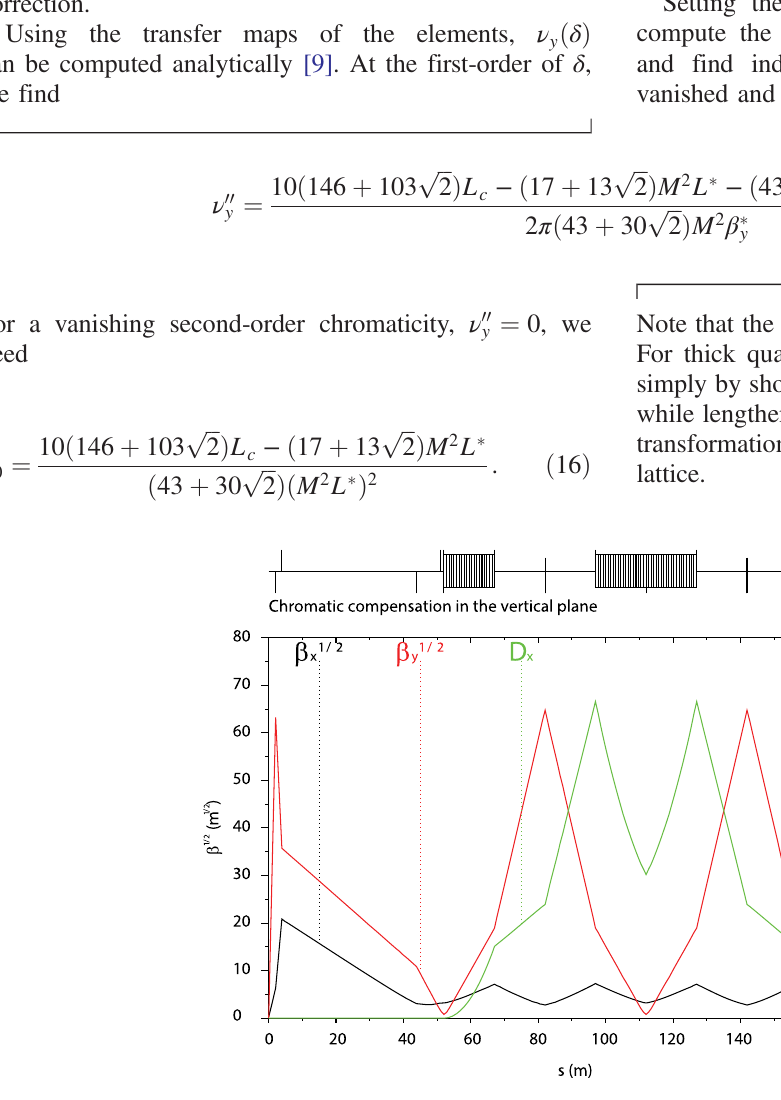
FIG. 8. Lattice functions in a final focusing system with local chromatic compensation section. The parameters in the chromatic correction module are L c ¼ 30 m and ϕ ¼ π = 500